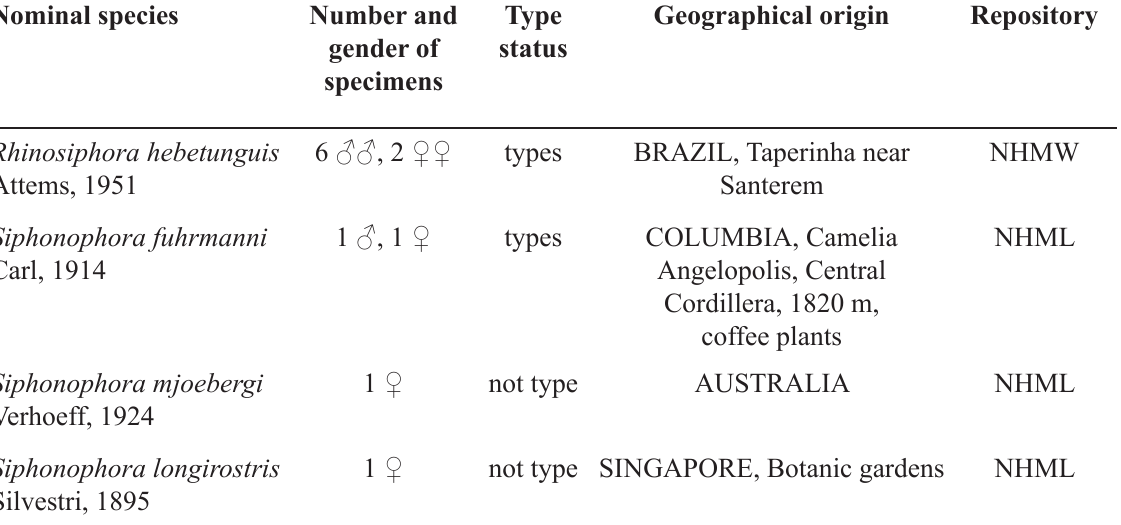
Table 3. Siphonophorid specimens studied for comparison with the new Brazilian material.